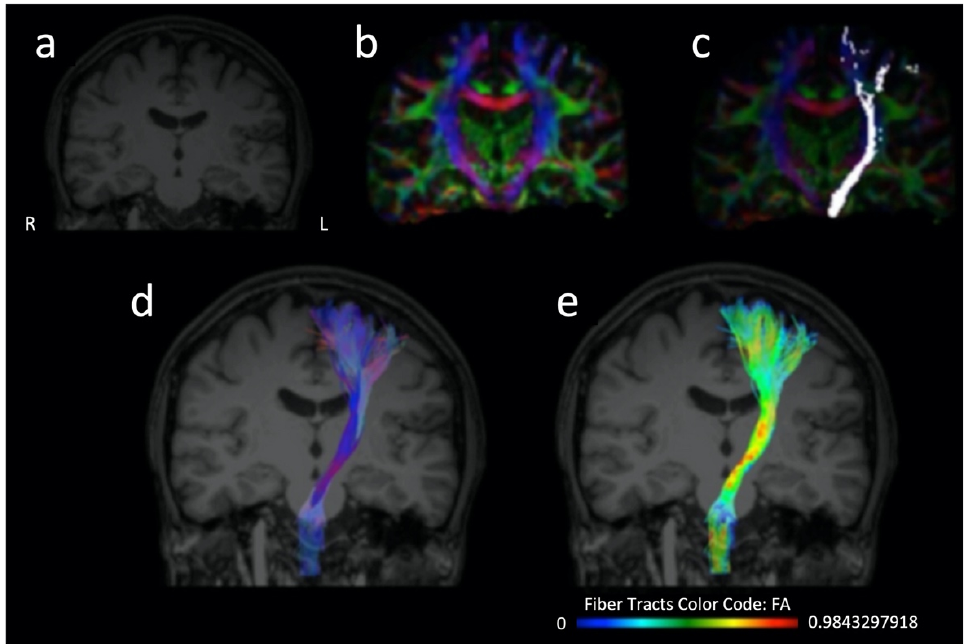
Figure 2. Three-dimensional T1 sequence ( a ), color fractional anisotropy map ( b ), distribution of the corticospinal tract fibers projected over a color fractional anisotropy map ( c ), three dimensional representation of the corticospinal tract ( d , e ) which is further color-coded according to the distribution of the fractional anisotropy values along the tract ( e ) and projected over a T1 sequence ( d , e ). The reconstruction of the corticospinal tract has been performed on a healthy subject (who provided written informed consent for the data acquisition, analysis and presentation) using the Brainance MD platform (Advantis Medical